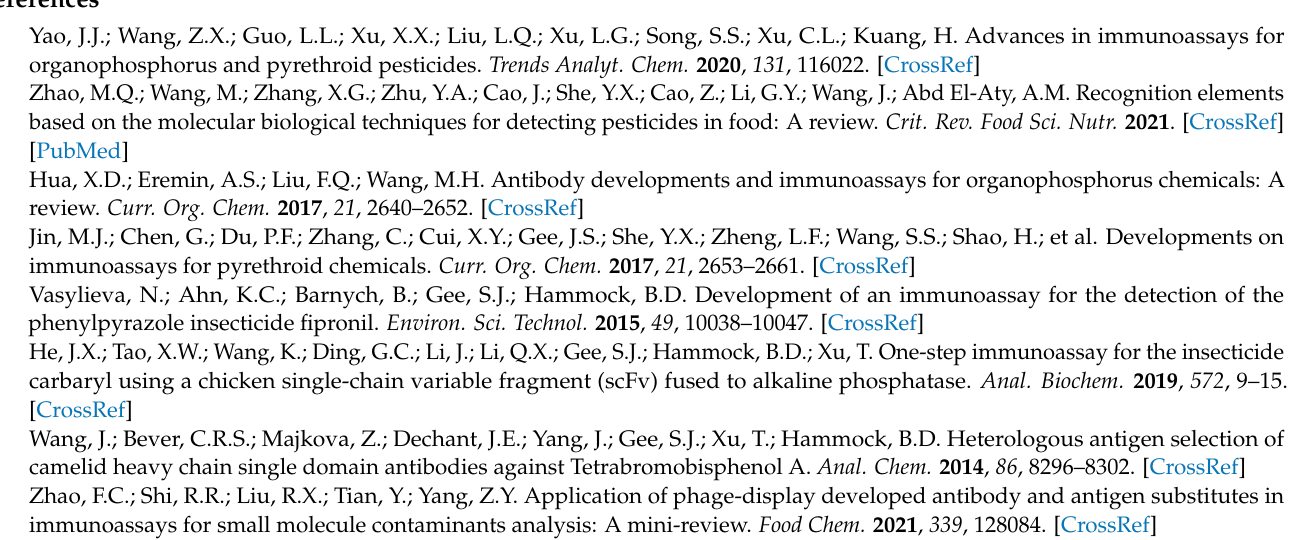
Figure S3: Matrix effects of noncompetitive P-ELISA; Table S1: Phage titer among panning; Table S2: Optimization of mAb concentrations and phage inputs in competitive P-ELISA; Table S3: Comparison of reported ELISAs for